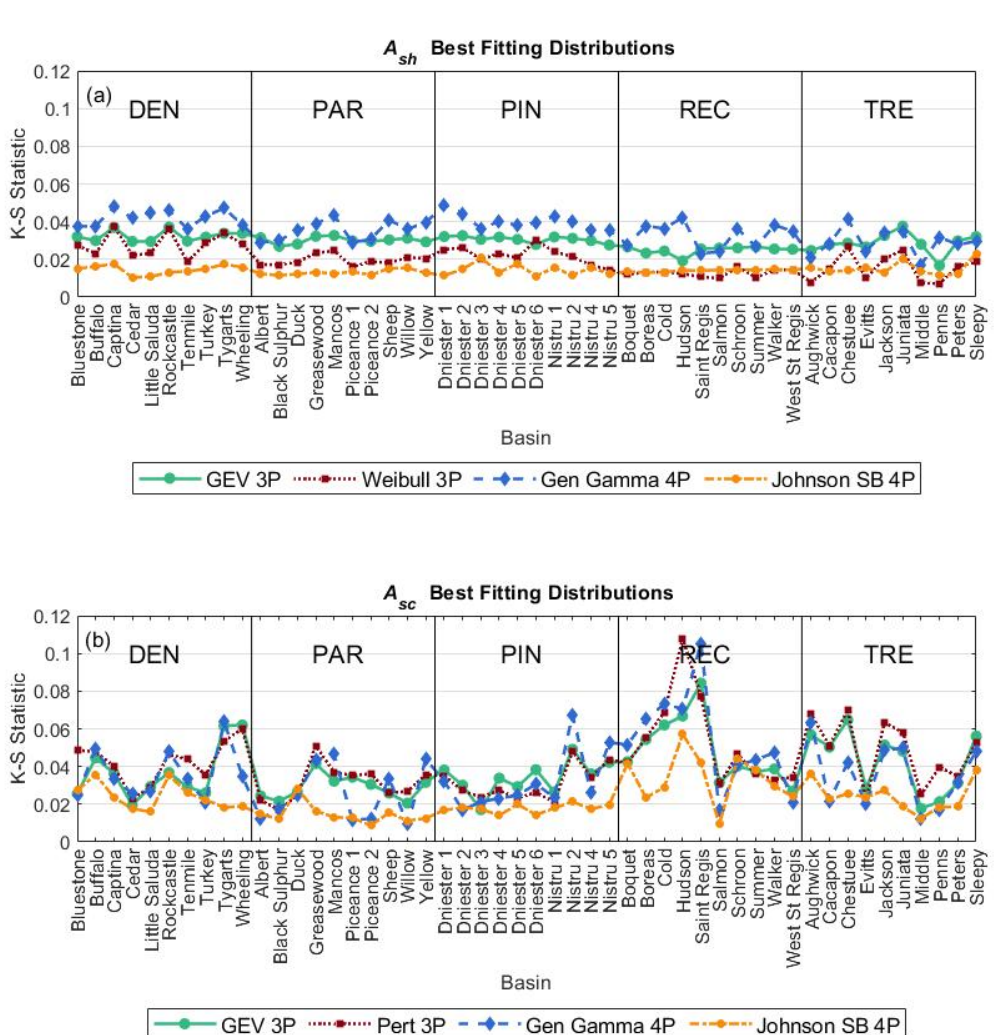
Figure 2. Kolmogorov-Smirnov (K-S) statistics for the four best fitting distributions for ( a ) A sh and ( b ) A sc . DEN denotes dendritic, PAR denotes parallel, PIN denotes pinnate, REC denotes rectangular, and TRE denotes trellis.